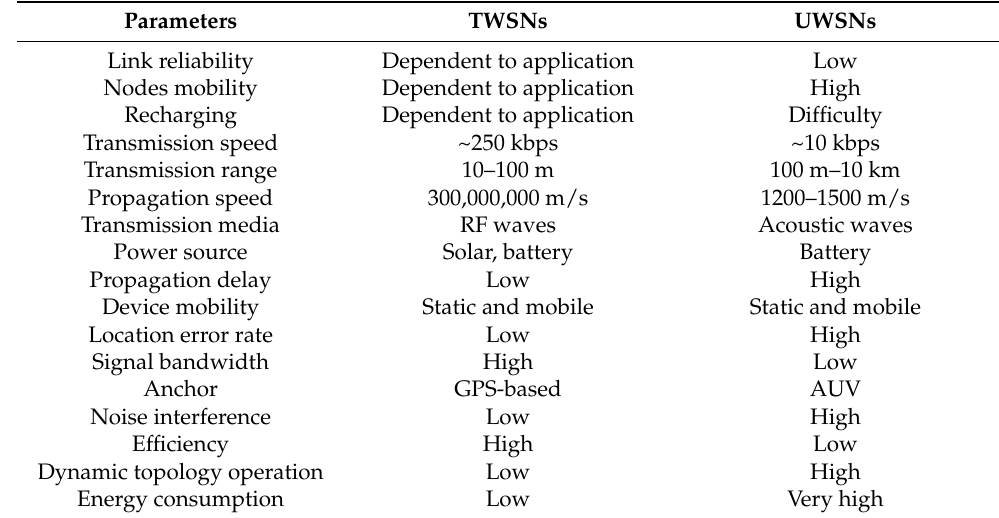
Table 5. Differences between TWSNs and UWSNs.